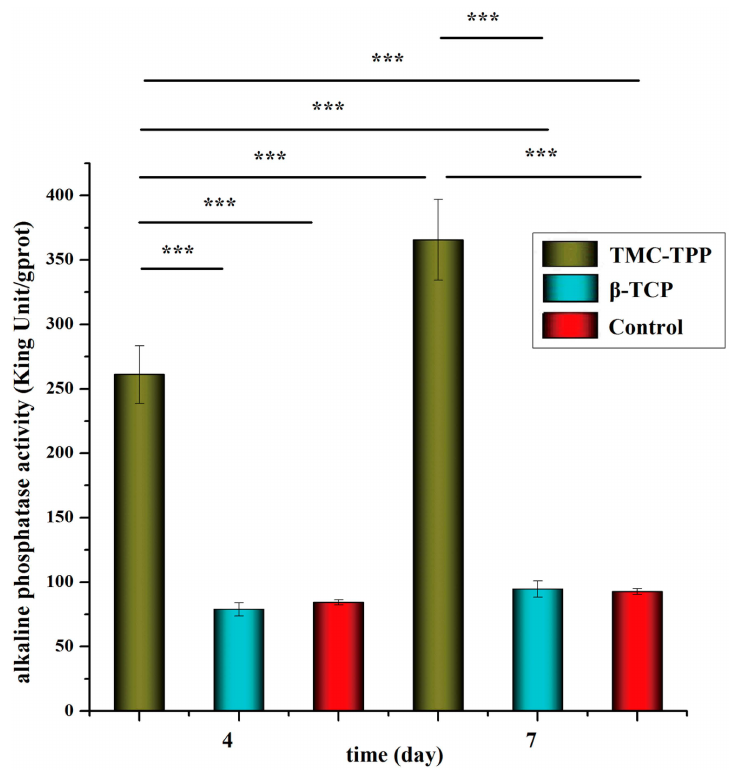
Figure 9. ALP activity of OBs exposed to TMC-TPP nanoparticles and β -TCP suspension. *** , p <